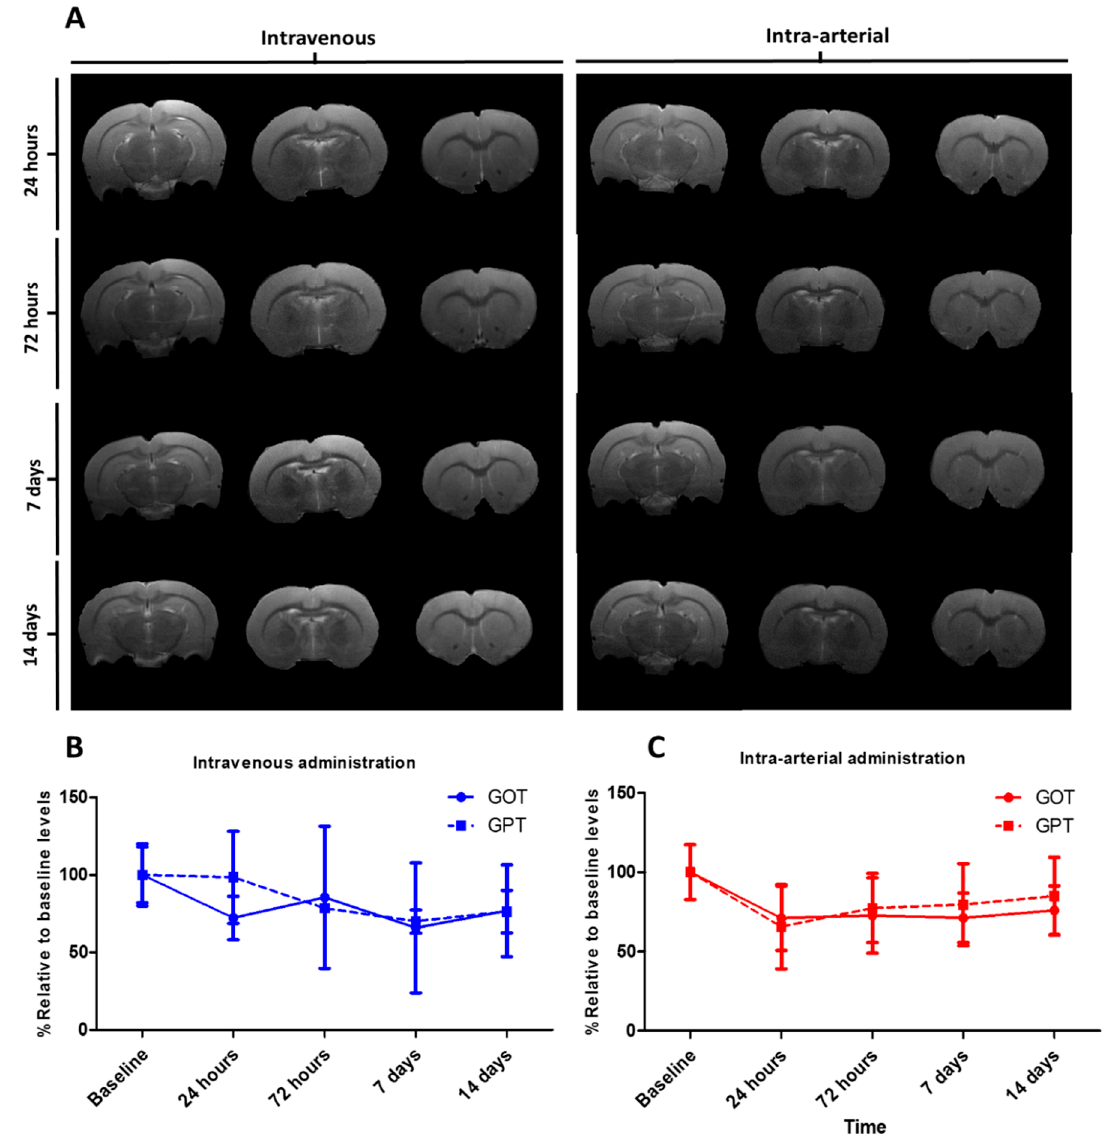
Figure 14. ( A ) T2 weight images after intravenous and intra-arterial administration of 1.4 mg/kg of HMMSN hybrid magnetic mesoporous nanorods. ( B , C ) GOT and GPT levels normalized to baseline at different time points after intravenous and intra-arterial administrations, respectively. (N = 3/group).